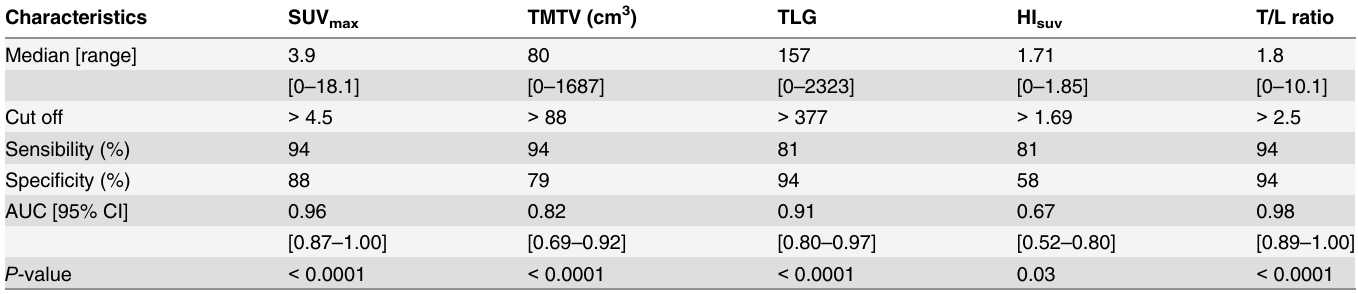
Table 3. Performance of PET/CT metabolic parameters to distinguish sarcoma from benign NF, dysplastic NF and no sign of transformation at fol- low-up (n = 49).